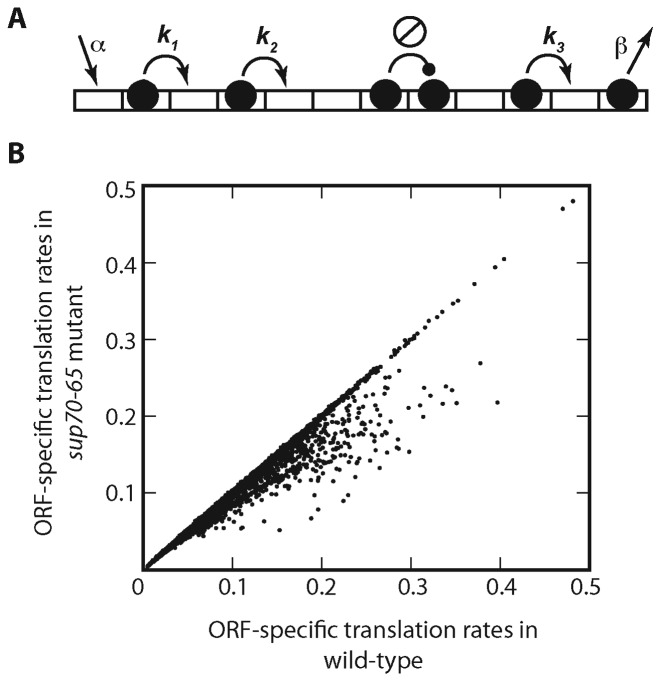
Modelling ribosome flux on the total yeast transcriptome identifies the targets of glutamine \documentclass[12pt]{minimal}
\usepackage{amsmath}
\usepackage{wasysym}
\usepackage{amsfonts}
\usepackage{amssymb}
\usepackage{amsbsy}
\usepackage{upgreek}
\usepackage{mathrsfs}
\setlength{\oddsidemargin}{-69pt}
\begin{document}
}{}${\rm{tRNA}}_{{\rm{CUG}}}^{{\rm{Gln}}}$\end{document} regulation. (A) Mathematical modelling of ribosome flux along each mRNA employed a Totally Asymmetric Simple Exclusion Process (TASEP) in which ribosomal particles of 9-codon width join a lattice representing the mRNA with rate α, and translate the lattice, codon by codon using 2-state dynamics. These are defined by cognate tRNA finding rate ki, dictated by tRNA abundance, and translocation rate γ for ribosomes charged with the cognate tRNA, not shown in the figure (67). Ribosome then terminate with rate β. (B) The TASEP model was used to simulate in turn each of the 5500 yeast mRNAs using published initiation and stepping rates (29). Simulations were performed using wild-type tRNA concentrations, and again using a concentration of \documentclass[12pt]{minimal}
\usepackage{amsmath}
\usepackage{wasysym}
\usepackage{amsfonts}
\usepackage{amssymb}
\usepackage{amsbsy}
\usepackage{upgreek}
\usepackage{mathrsfs}
\setlength{\oddsidemargin}{-69pt}
\begin{document}
}{}${\rm{tRNA}}_{{\rm{CUG}}}^{{\rm{Gln}}}$\end{document} reduced to 25% of normal levels to mimic the sup70-65 mutant as determined experimentally (6). Translation rates for each mRNA under the two conditions are plotted.